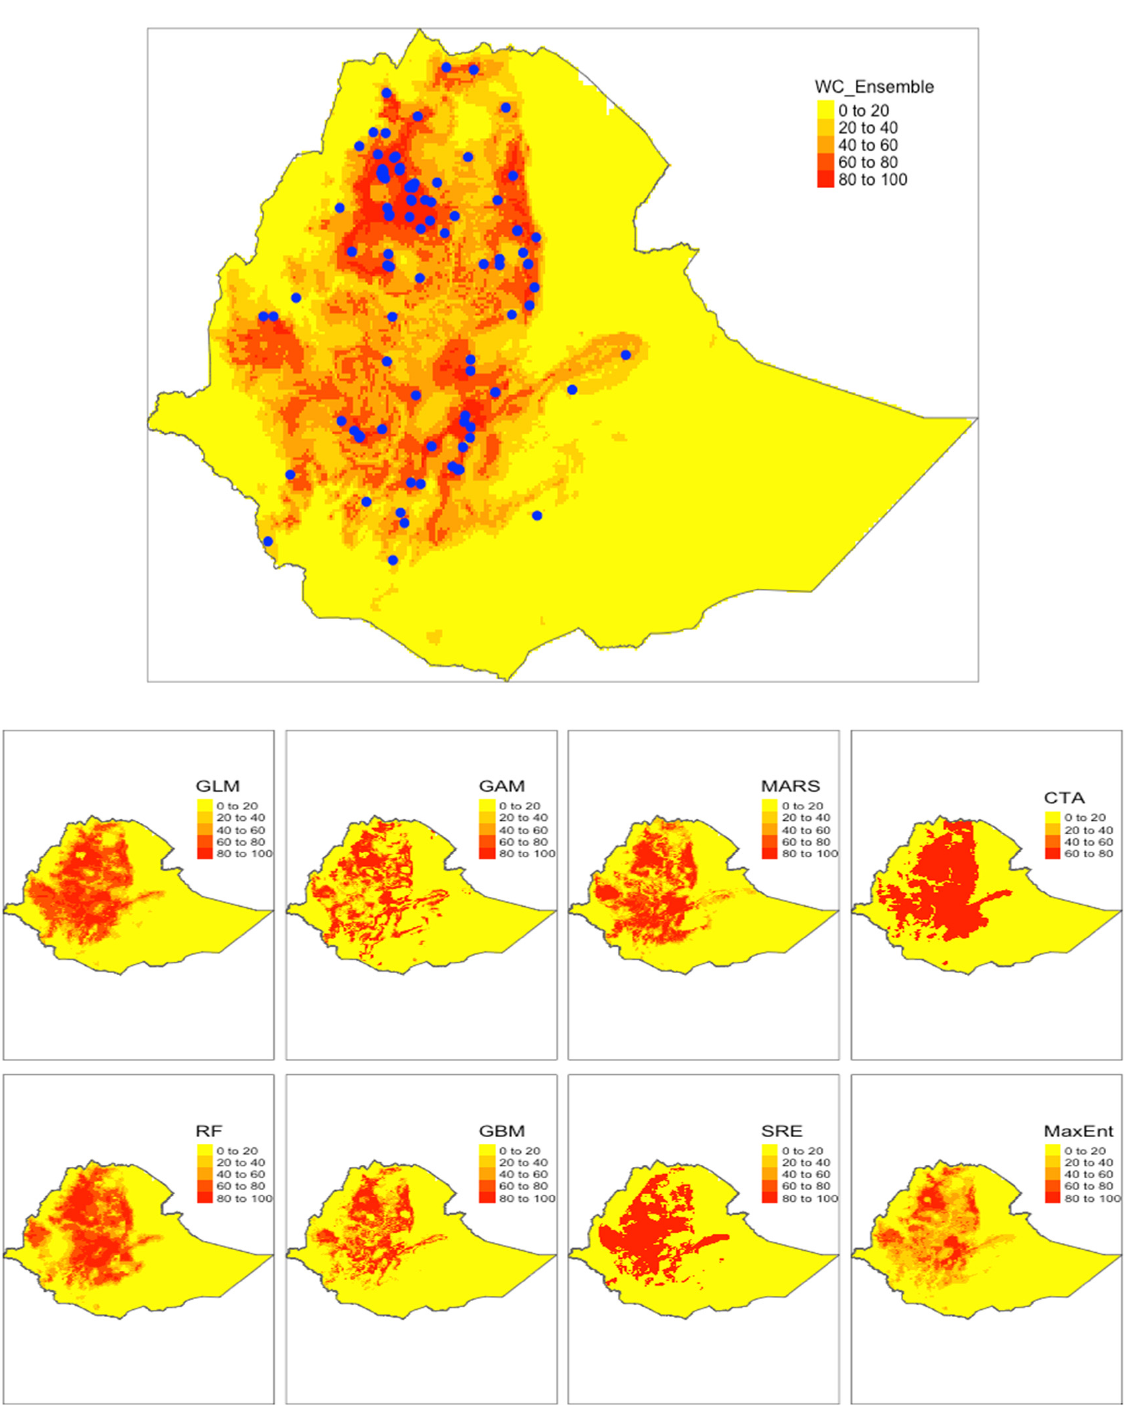
Figure 3. WC-based results showing potential distribution of S. mansoni endemic areas in Ethiopia from different models. Blue dots represent the occurrence locations. Legend shows a probability of occurrence given the environmental suitability ranging from 0 to 100 percent.